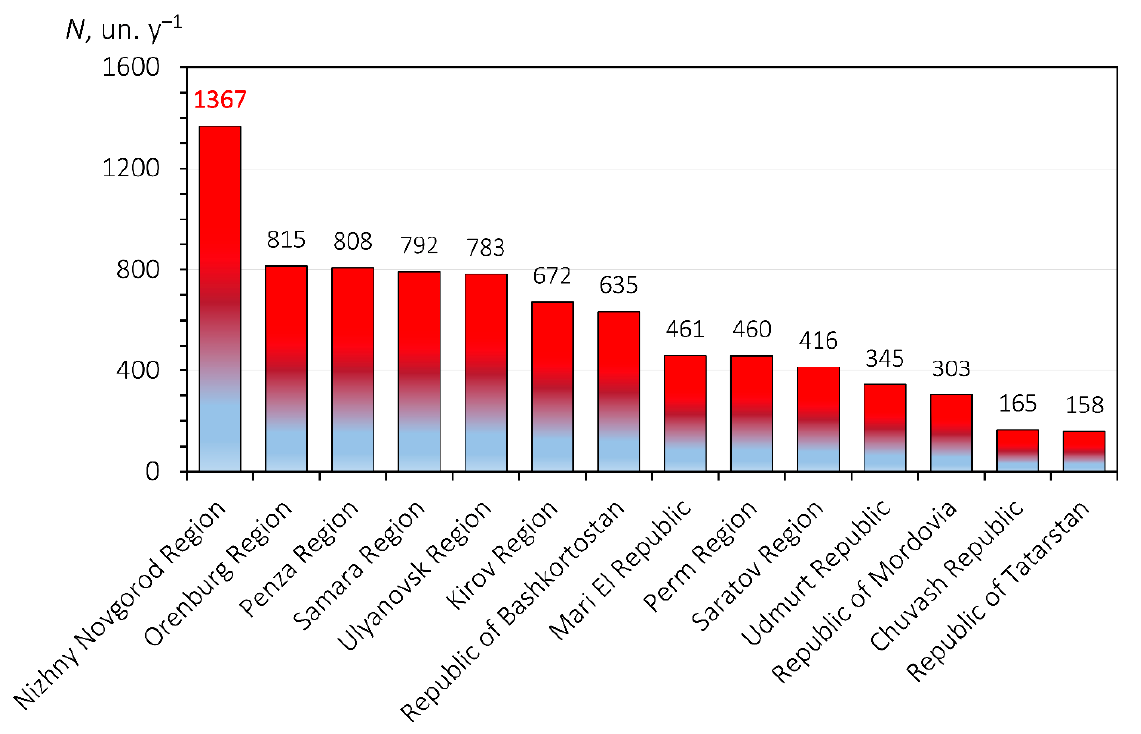
Figure 4. The number of forest fires ( N ) in 2010 by the administrative regions of the Volga Federal District (see Figure 1).